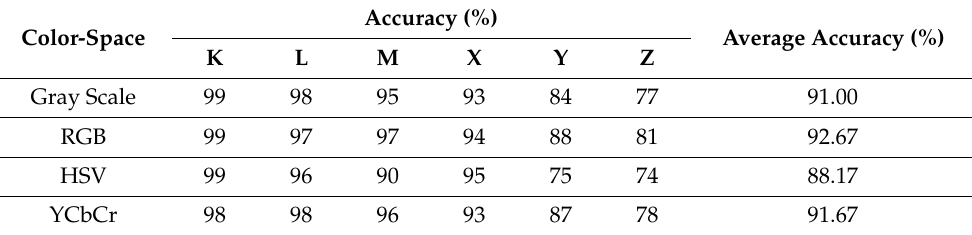
Table 12. Comparison of the results obtained using different color-spaces with occlusion by scarf.